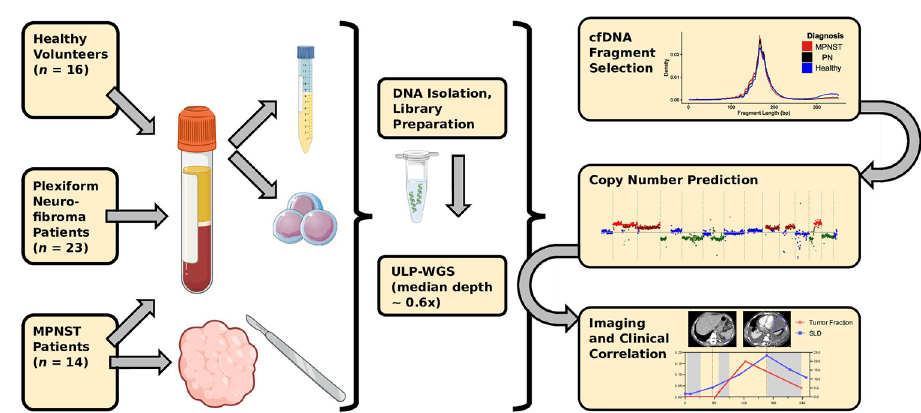
Fig 1. Study schema. Patients with imaging- and biopsy-proven MPNST and established PN along with healthy donors were enrolled onto this multi-institutional prospective cohort, with plasma collected for tumor fraction analysis at the time of study enrollment. Tumor fraction was assessed in all collected plasma samples by ULP-WGS followed by in silico size selection for short cfDNA fragments, which was used to train a noninvasive MPNST vs. PN classifier. During subsequent treatment and follow-up, MPNST patients underwent further serial imaging (analyzed by RECIST) and plasma sample collection (analyzed by ULP-WGS and in silico fragment size selection), with results correlated with each other and with clinical outcomes. cfDNA, cell-free DNA; MPNST, malignant peripheral nerve sheath tumor; PN, plexiform neurofibroma; RECIST, response evaluation criteria in solid tumors, version 1.1; SLD, sum of longest tumor diameters; ULP-WGS, ultra-low-pass whole genome